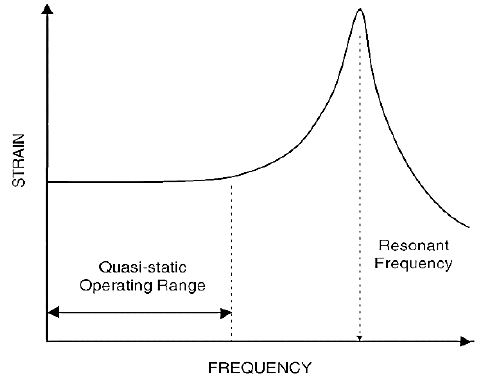
Figure 5. Typical resonant characteristic of a piezoelectric transducer.